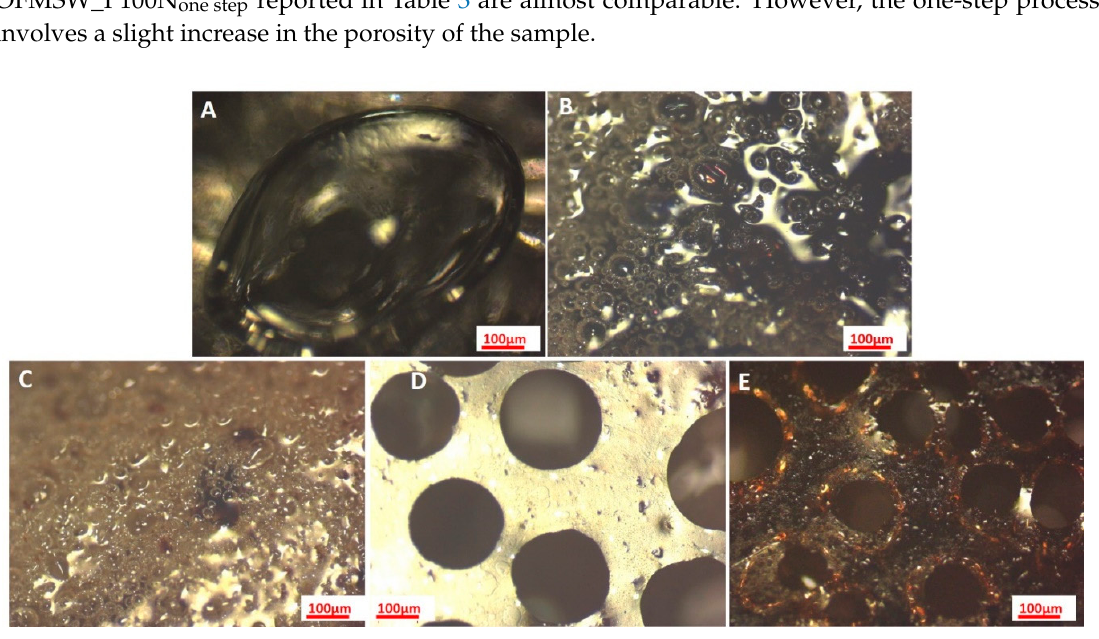
Figure 7. Optical microscope analysis of P100N ( A ), OFMSW_P100N dual step ( B ), OFMSW_P100N one step ( C ), with sawdust as additive - OFMSW_P100N_10s_one_step ( D ) and with coffee powder added - OFMSW_P100N_10c_one_step. ( E ) samples (magnification 50X). Table 3. Average dimension of the pores of one step and dual step process cured samples .